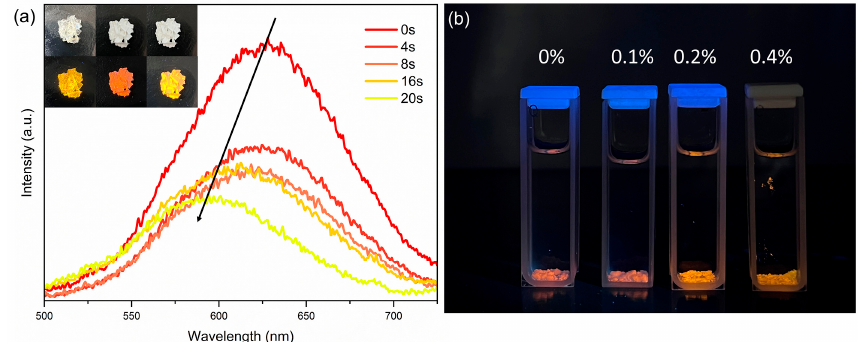
Figure 6. ( a ) The in situ PL spectra for humidity-sensing application; the red-emissive [H 2 BPZ][SbCl 5 ] can be transformed to yellow-emissive [H 2 BPZ][SbCl 5 ]•H 2 O within 20 s under the ambient condition. Inset: the photographs of [H 2 BPZ][SbCl 5 ]•H 2 O power under ambient light (top) and UV light (bottom); from left to right: freshly prepared crystals, samples after heating at 100 °C for 30 min, dehydrated samples placed in ambient condition. ( b ) Dehydrated [H 2 BPZ][SbCl 5 ] in acetone solvent containing different amounts of water (0–0.4% v / v ).